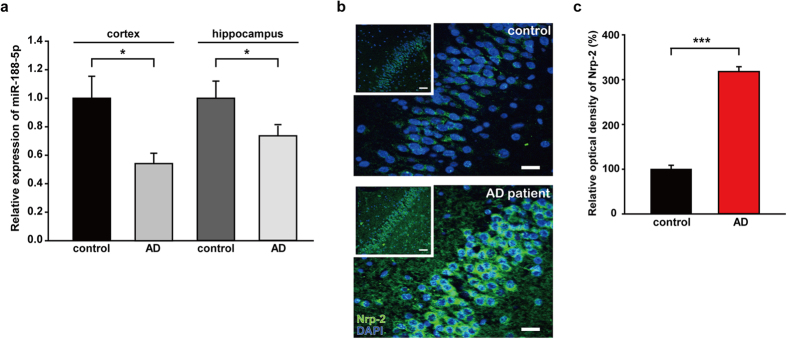
miR-188-5p was significantly down-regulated in the brains from AD patients.(a) miR-188-5p expression was examined by RT-qPCR in brains from AD patients and age-matched control subjects. miR-188-5p expression was significantly down-regulated in cerebral cortices (n = 3, vs. age-matched control subjects, n = 4, Mann-Whitney test) and hippocampi (n = 6, vs. age-matched control subjects, n = 4, Student’s t-test) of AD patients. (b) Representative images of the dentate gyrus of AD patients (98-year-old) compared with an age-matched control subjects. Nrp-2 immunoreactivity was measured by immunohistochemistry. Scale bars, 50 μm (inset, white square box) and 20 μm (magnified panel). (c) Quantitative graphs for Nrp-2 immunoreactivity in age-matched control subjects and AD (n = 3, Mann-Whitney test) and hippocampi (n = 4, Student’s t-test). Data are represented as the mean ± SEM. *p < 0.05, ***p < 0.001 compared to age-matched control subjects.